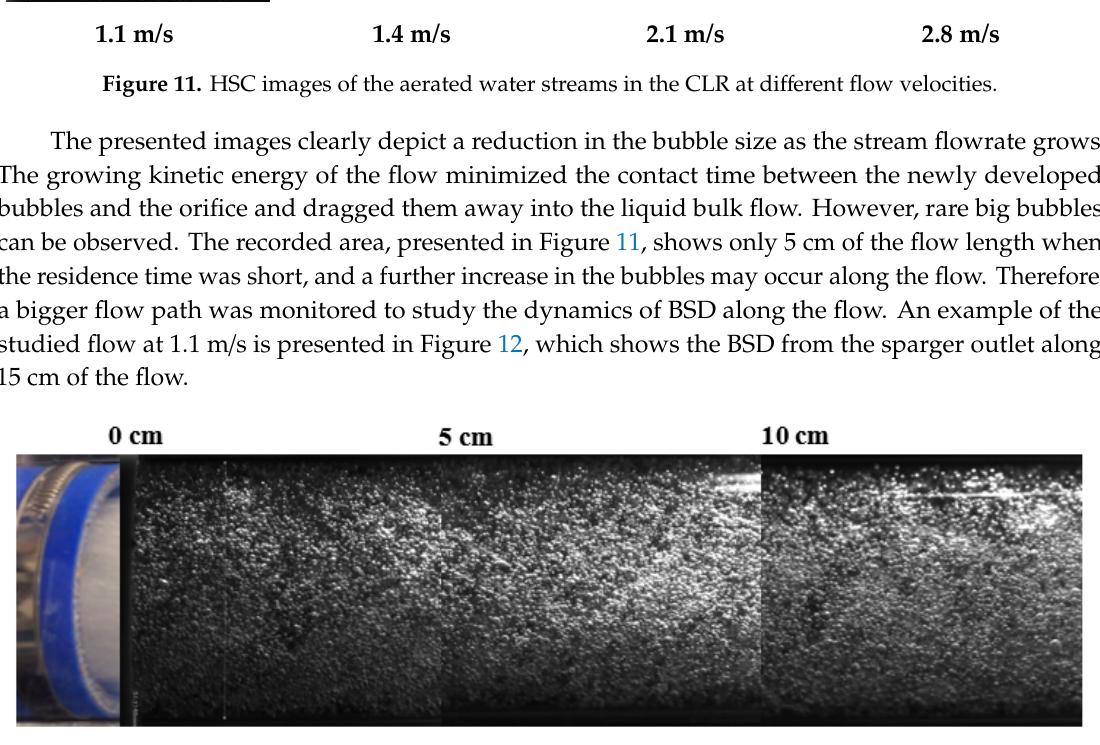
Figure 13. Mean bubble size in the aerated water flow at different stream flow rates. The circle marks denote the results from PIV, while the rhomboids are from HSC. An almost linear reduction in the bubble size occurred at the beginning of the stream velocity elevation. However, the trend followed a power-law relation as the energy of the bubble surface tension grows faster than that of the flow stream. In turn, the elevated energy of the stream was able to handle higher gas hold-ups that increased the ability of the pressurized air supply to increase the oxygenation rate. Bubble size distribution can be effectively controlled in the range of 1000–2500 μ m and 190–600 μ m correspondingly at the lowest and highest flow rates.